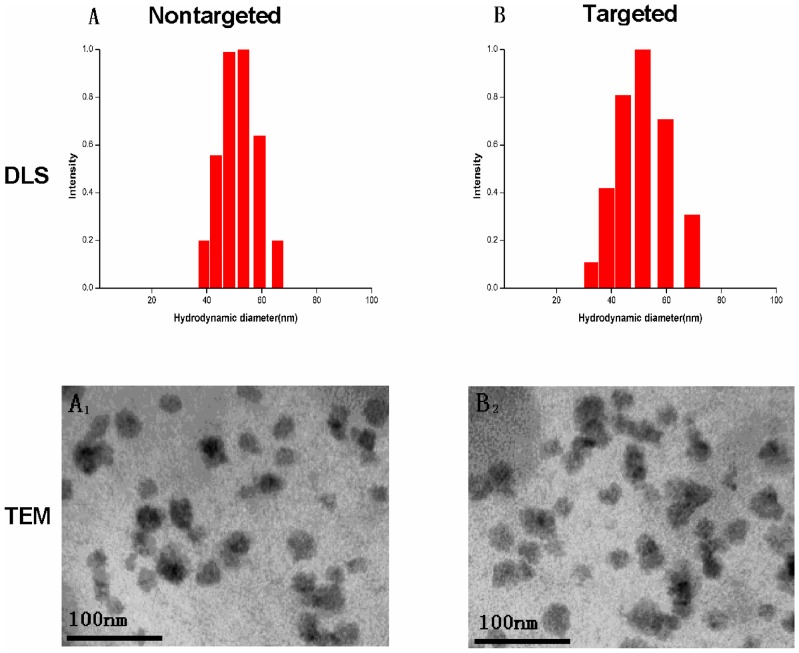
The representative DLS graphs of the DTX-PMs1 (A), and DTX-PMs2 (B), respectively.TEM graphs of DTX-PMs1 (A1) and DTX-PMs2 (B2).